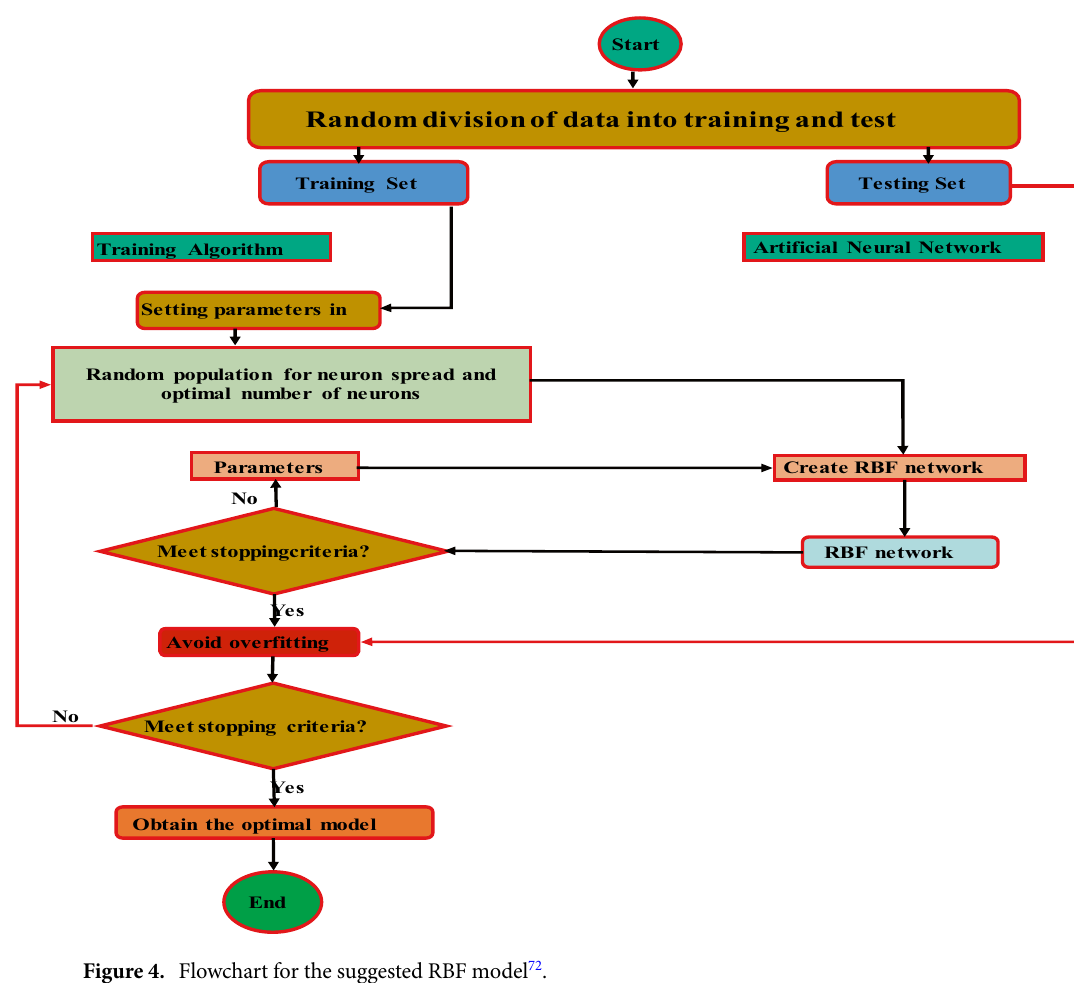
Figure 4. Flowchart for the suggested RBF model 72